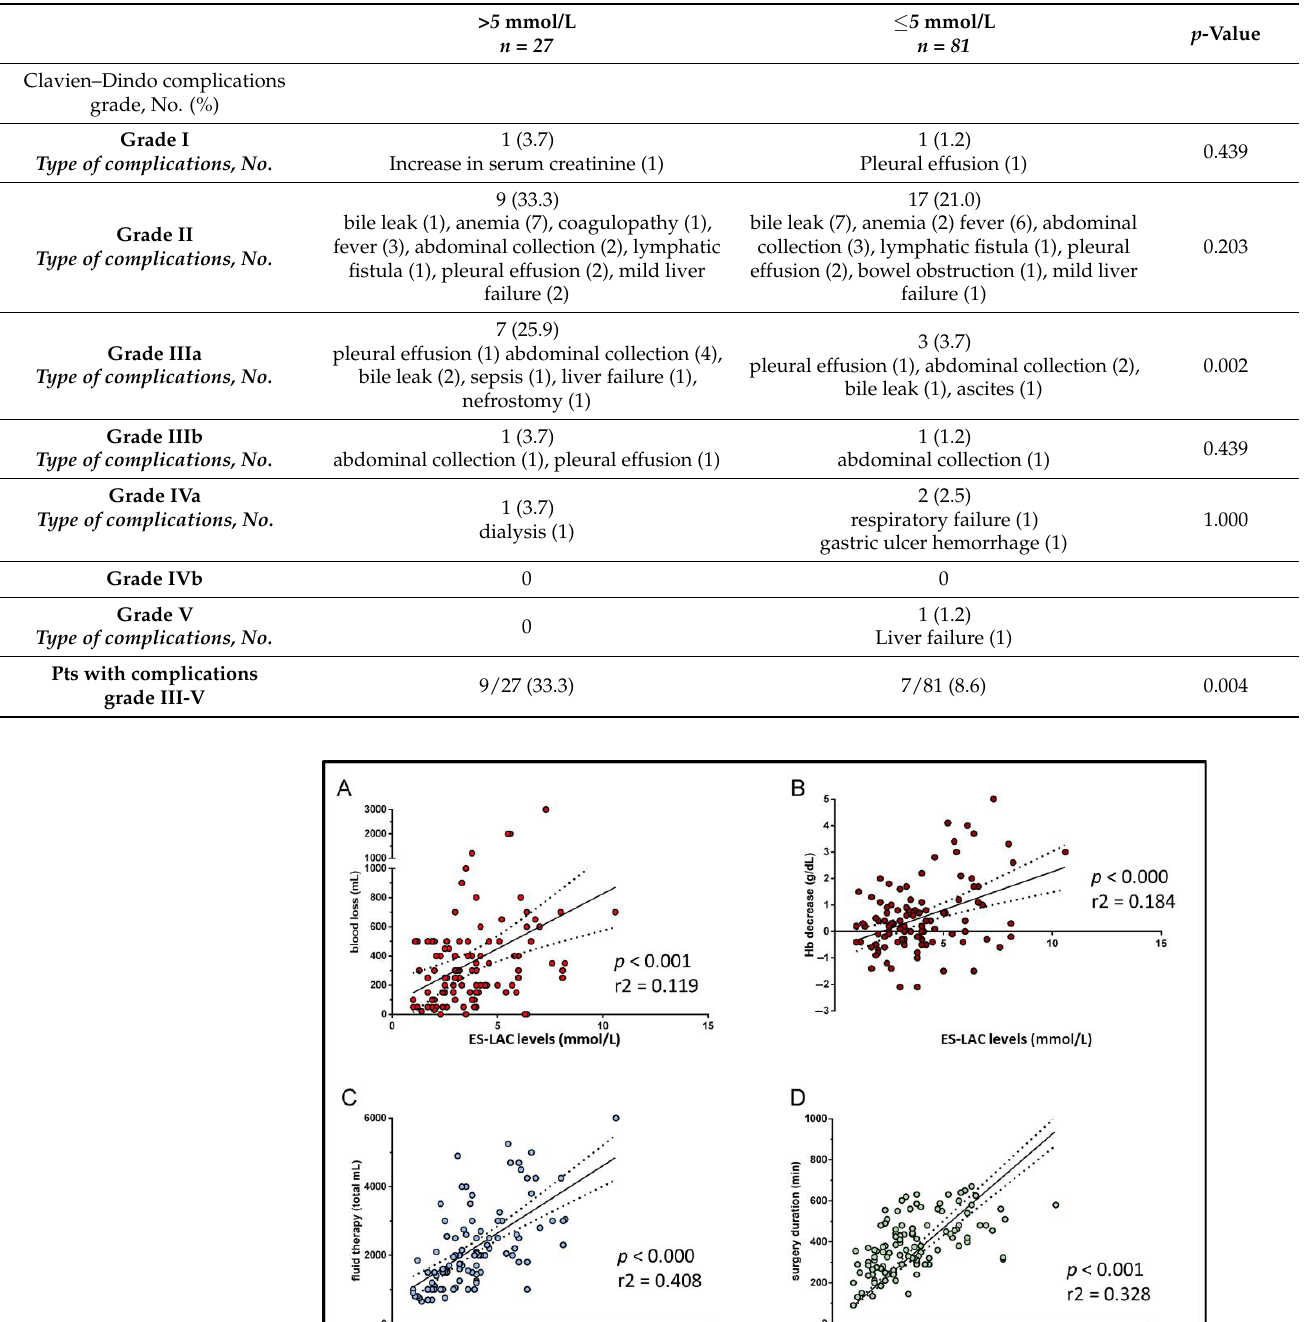
Table 5. Correlation between ES-ALC and postoperative complications.